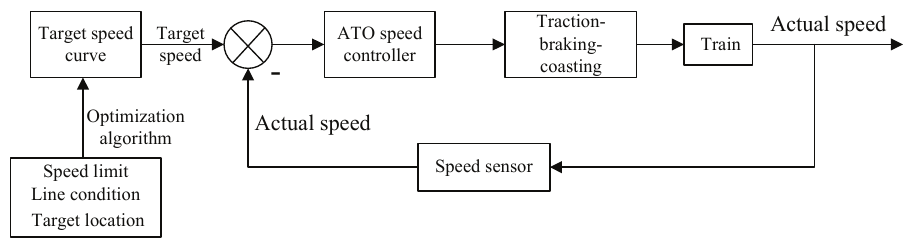
Figure 1. Control principle of the automatic train operation (ATO) system.